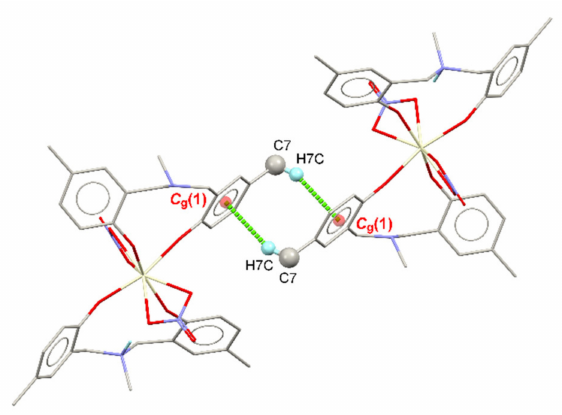
Figure 5. A view displaying the pair of C7–H7C · · · C g (1) contacts joining two molecules of the Ce-MMD complex related by an inversion